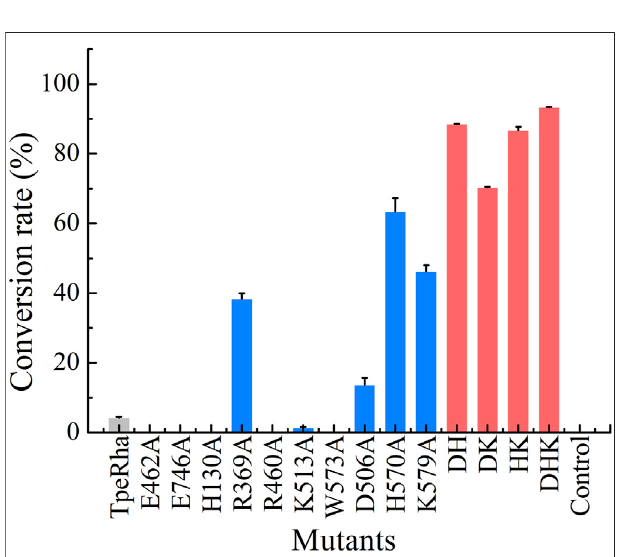
FIGURE 2 | The whole-cell catalysis screening results of mutants designedinthisstudyareshowninthreecoloredbars(wild-typeshowninlight gray,single-pointmutantsshowninblue,andmultiple-pointmutantsshownin red). The conversation rate of the wild-type TpeRha was 4.33% ± 0.19%, while the control was product undetected. DHK had the highest conversion rate of 93.32% ±